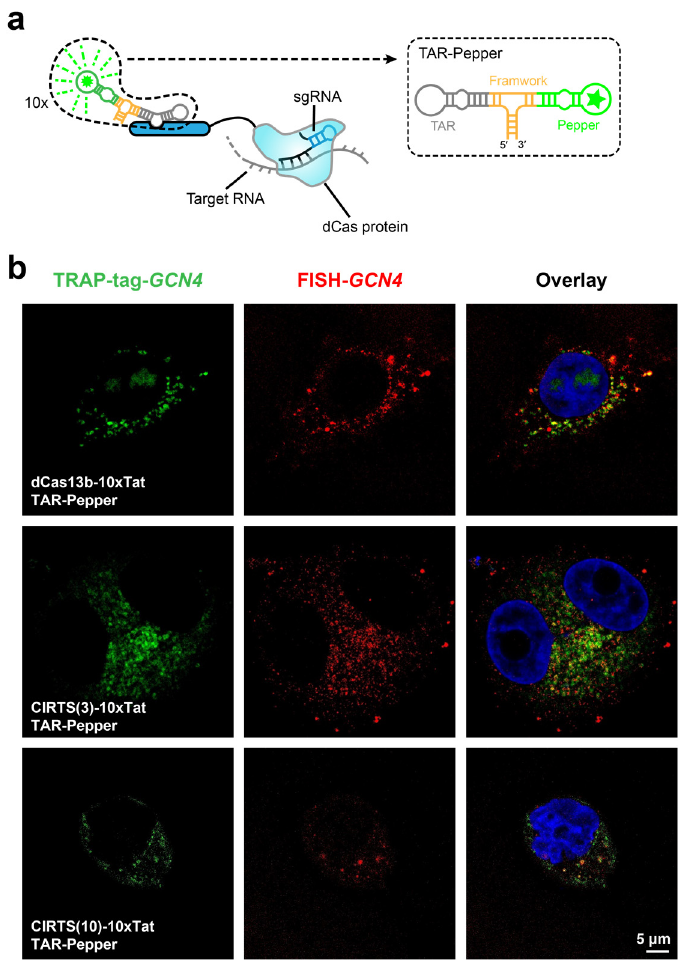
Figure 5. CRISPR-TRAP-tag systems were compatible with the RNA aptamer Pepper. ( a ) Scheme of the strategy for Pepper version of CRISPR-TRAP-tag systems. ( b ) Representative images of GCN4 labeled using CRISPR-TRAP-tag with RNA aptamer Pepper with gRNAs.